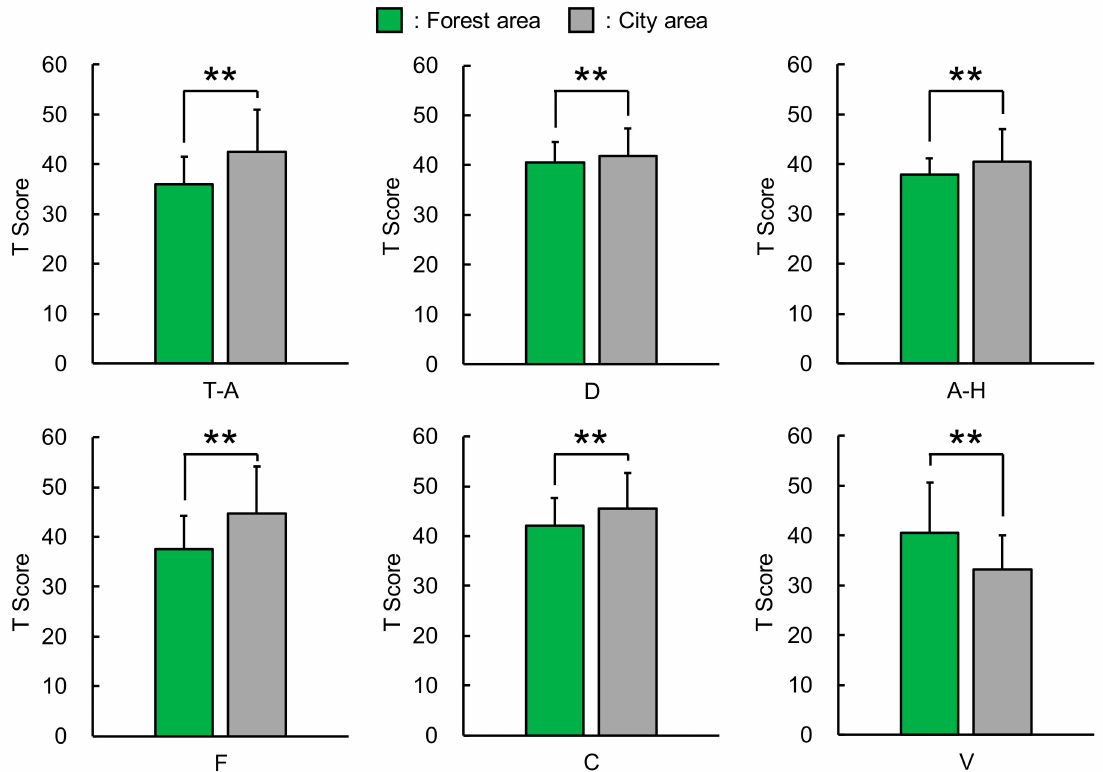
Figure 2. Profile of Mood States scores after observing city and forest areas. T–A, tension–anxiety; D, depression–dejection; A–H, anger–hostility; F, fatigue; C, confusion; and V, vigor. n = 649–650; mean ± standard deviation; ** p < 0.01 decided by the Wilcoxon signed-rank